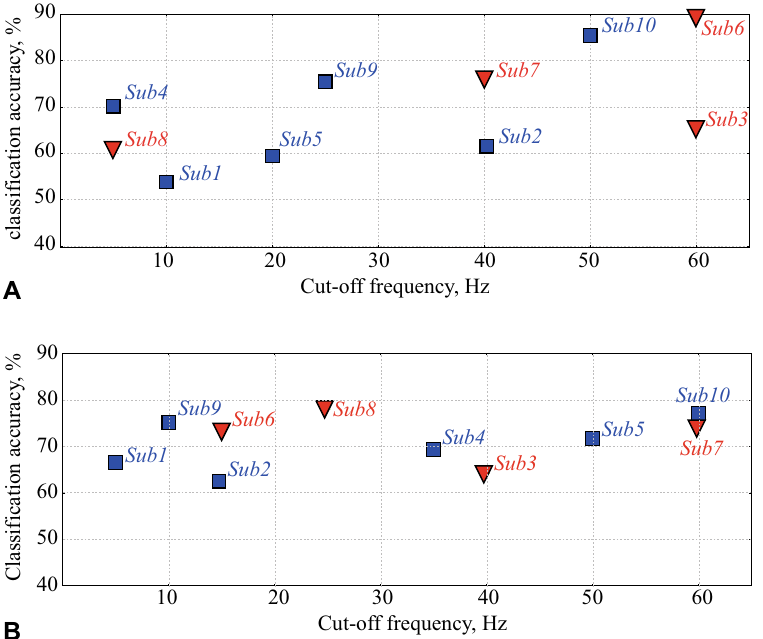
Figure 6. ANN classification accuracy of MI of left and right arms versus cut-off frequency for KI (squares) and VI (triangles) subjects, obtained using ( A ) 102 and ( B ) 13 channels. Each data point indicates the maximal value of the classification accuracy for every subject and the corresponding cutoff frequency F c , at which this maximal accuracy is